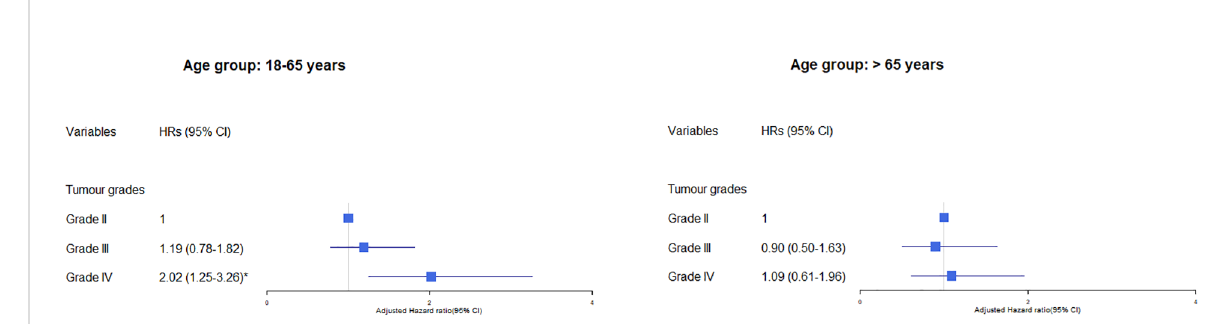
FIGURE 2 Association of tumour grade with cerebrovascular mortality in glioma patients by age group. The hazard ratios (HRs) were calculated using cox regression model and adjusted for variable shown, age, sex, race/ethnicity, marital status and calendar years. The reference group was those who did not receive the treatment: surgery, chemotherapy or radiation. CI, Con fi dence intervals. Signi fi cance code: *